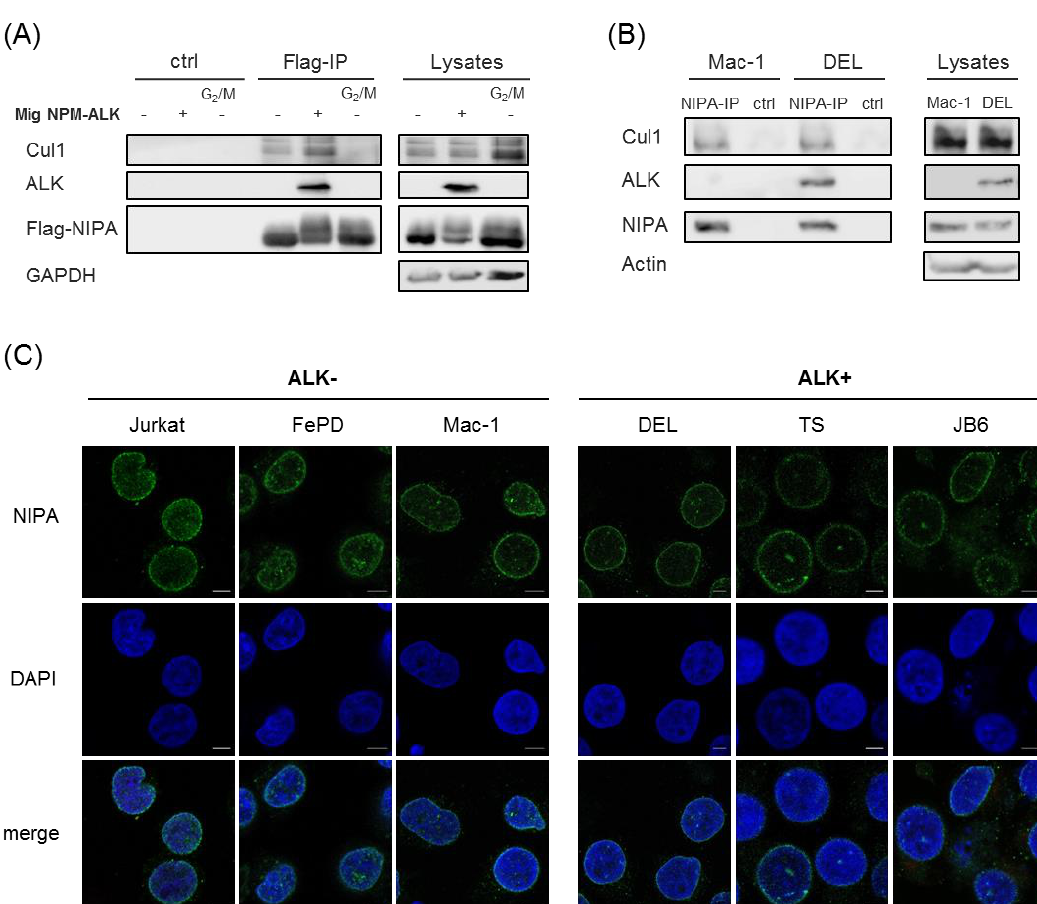
Figure 4. NPM-ALK-mediated NIPA phosphorylation does not change the SCF NIPA -complex formation but might influence the NIPA localization at the nucleus. ( A ) Hek293T cells were transiently transfected with pCDNA Flag hNIPA wt +/ − Mig NPM-ALK and used for Flag-IP. ( B ) ALK − ALCL cells (Mac-1) and ALK + ALCL cells (DEL) confirmed binding of the SCF-core-complex binding to endogenous NIPA. ( C ) ALK + and ALK − cells were used for immunofluorescence and displayed slight differences in endogenous NIPA localisation with a shift to the nuclear membrane in ALK + cells. NIPA was stained with Alexa Fluor 488 (green). DAPI (blue) was used to stain the nucleus (Scale bars: 5 µm).